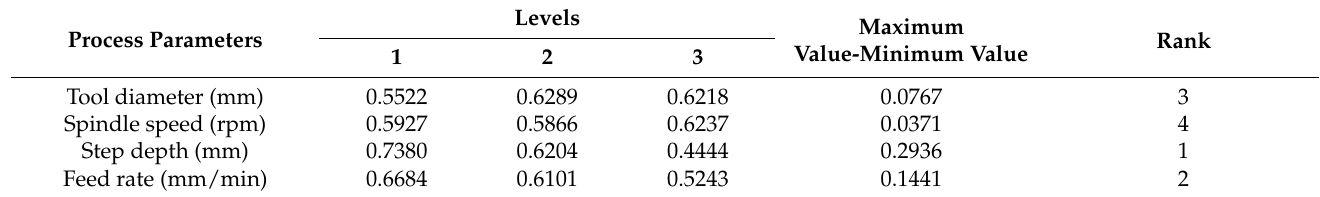
Table 7. Response of